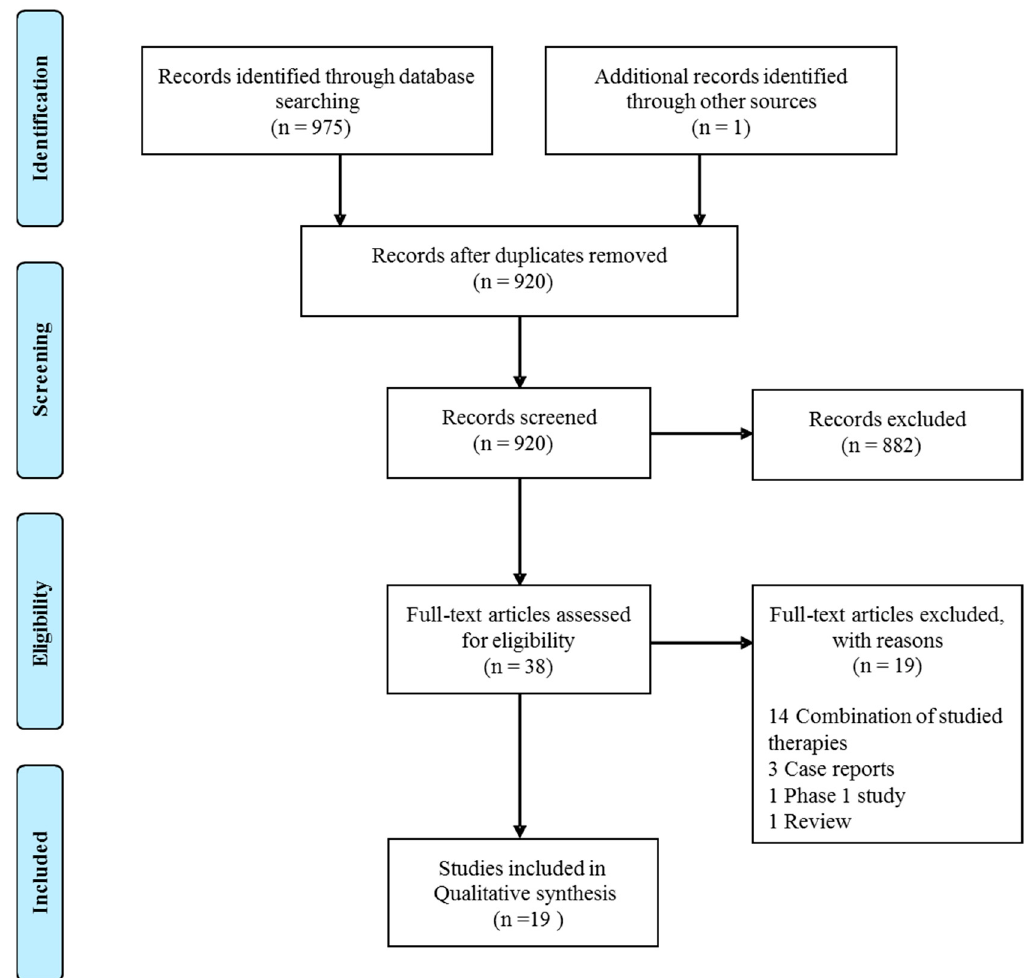
F igure 1 . Flow diagram of the article selection. Figure 1. Flow diagram of the article